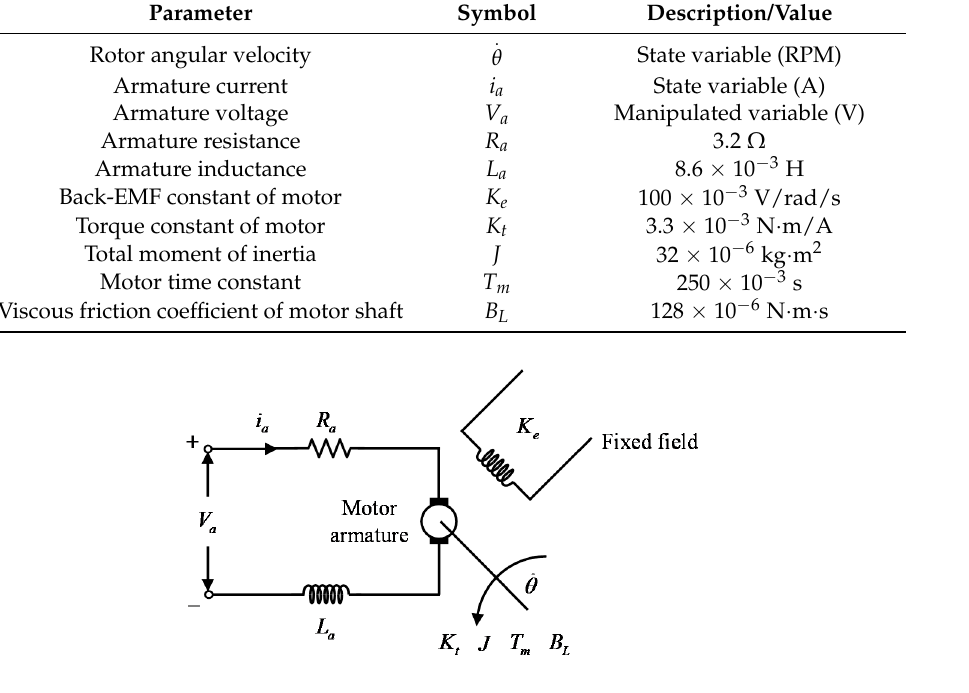
Figure 5. An armature-controlled DC motor.